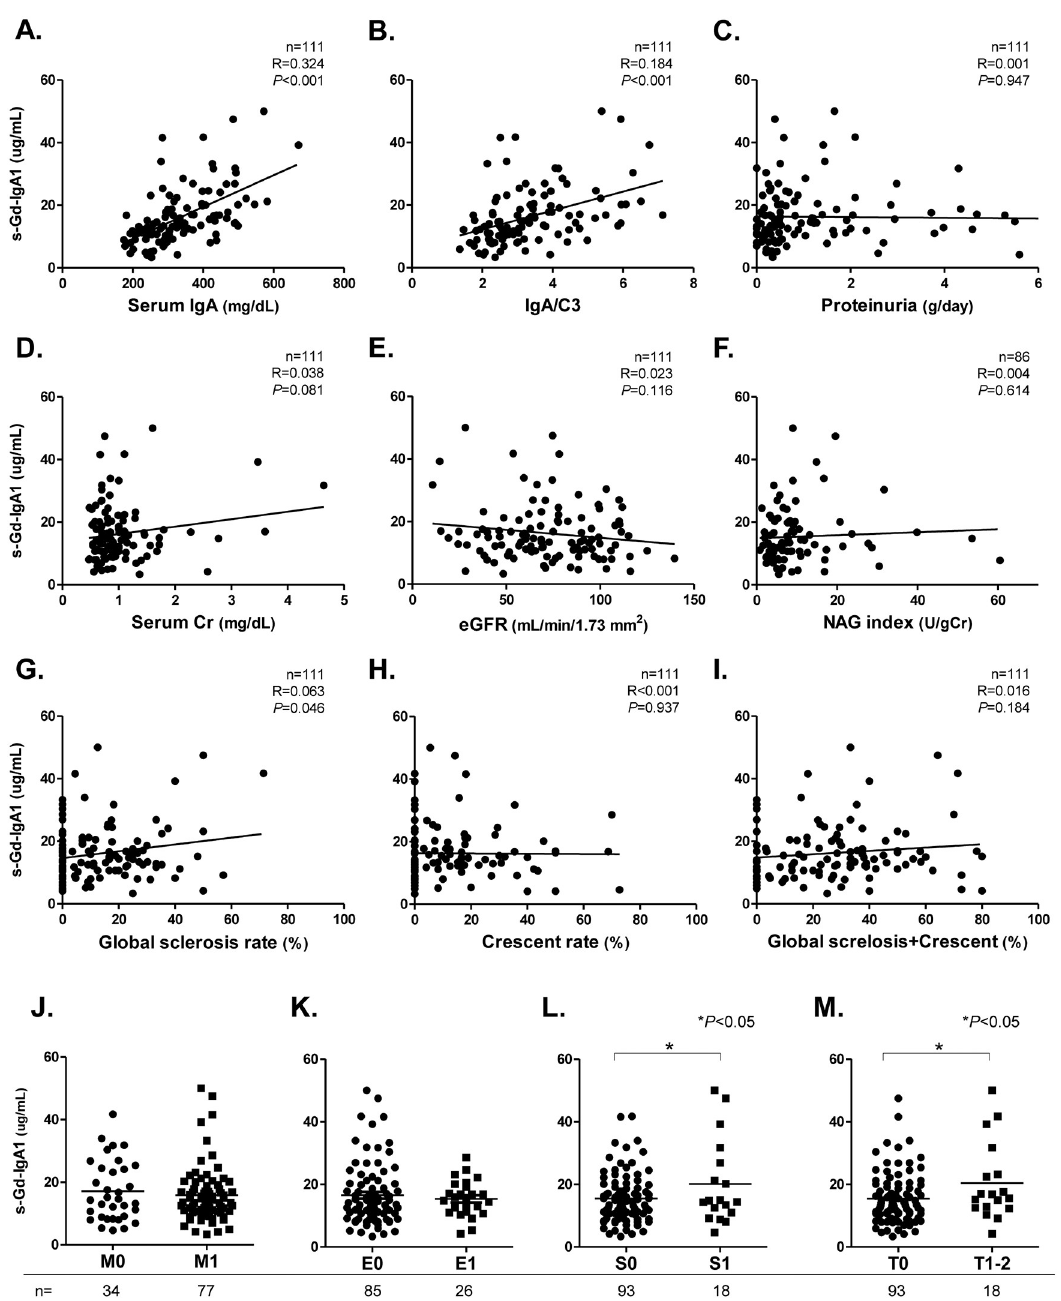
Fig 3. Correlations between s-Gd-IgA1 and laboratory parameters or pathological findings in patients with IgAN. Scatter plots of s-Gd-IgA1 vs. serum IgA (A) , serum IgA/C3 ratio (B) , proteinuria (C) , sCr (D) , eGFR (E) , urinary NAG index (F) , global sclerosis (G) , crescents (H) , and global sclerosis and crescents (I) . Rates of global sclerosis, crescents, and both types of glomerular lesions (%) were calculated by dividing total number of each type of lesion by total number of glomeruli. Crescents comprise cellular, fibrocellular, and fibrous types. S-Gd-IgA1 levels were compared based on Oxford classification ( J-M ). Patients with IgAN were assigned to groups according to mesangial hypercellularity ( J ), endocapillary hypercellularity ( K ), segmental glomerulosclerosis ( L ) and tubular atrophy/interstitial fibrosis ( M ). Horizontal solid lines represent means. Data were statistically analyzed using Mann- Whitney U tests and Spearman correlation tests.